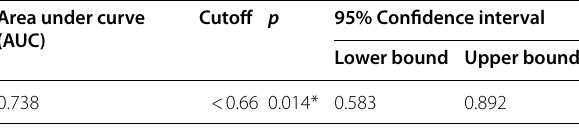
Table 6 Receiver operating characteristics (ROC) curve